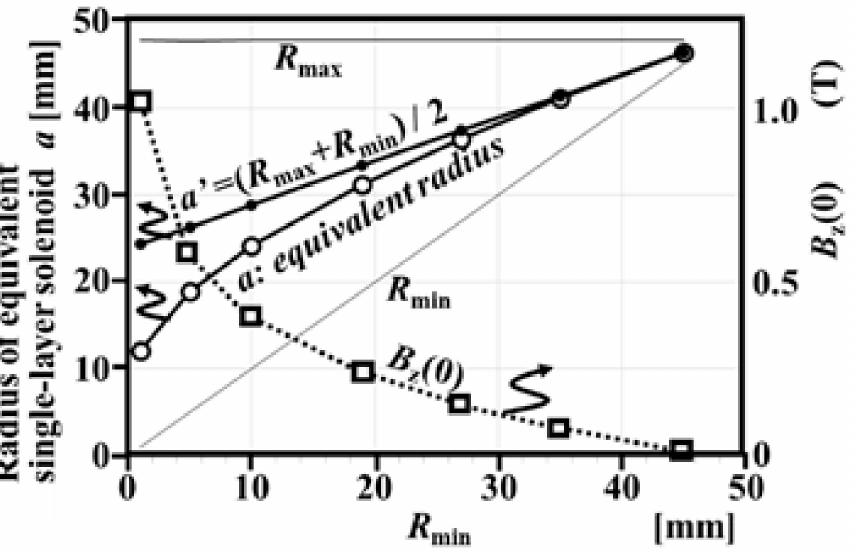
Figure 11. Calculated B z (0) at the center of the wafer as a function of R min . Radius a of the equivalent single-layer solenoid, which gives the same B z (0), is plotted as a function of R min . The mean radius of R max and R min , a ’, is also plotted for